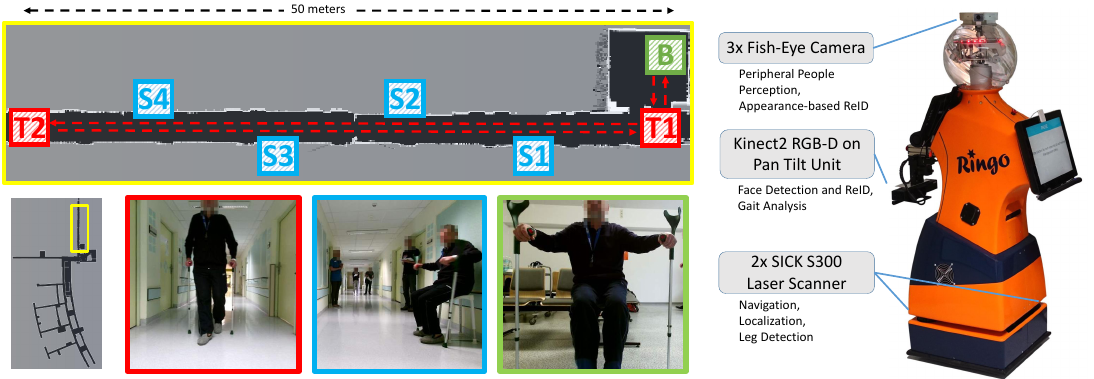
Figure 1. Application scenario in a rehabilitation clinic. Patients are escorted by the robot (on the right) while their gait patterns are analyzed in order to give advice for improving the self-training. Walks were along a populated aisle between T1 and T2, after the session started at B. At any time, the patient can take a rest at the provided chairs at S1–S4; that has to recognized by the robot in order to go to a waiting position until the training is